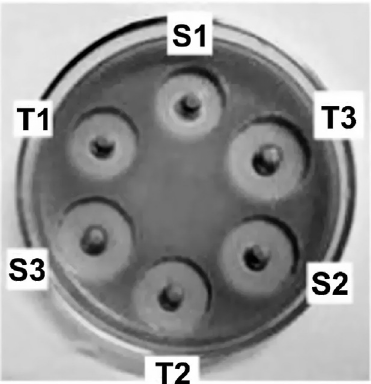
FIGURE 2 - An agar diffusion assay using a strain of S. aureus ATCC 25923 as the test microorganism. The chlorhexidine digluconate reference solutions are at concentrations of 0.5 (S1), 1.5 (S2) and 4.5% (S3) and the chlorhexidine digluconate samples are at concentrations of 0.5 (T1), 1.5 (T2) and 4.5%